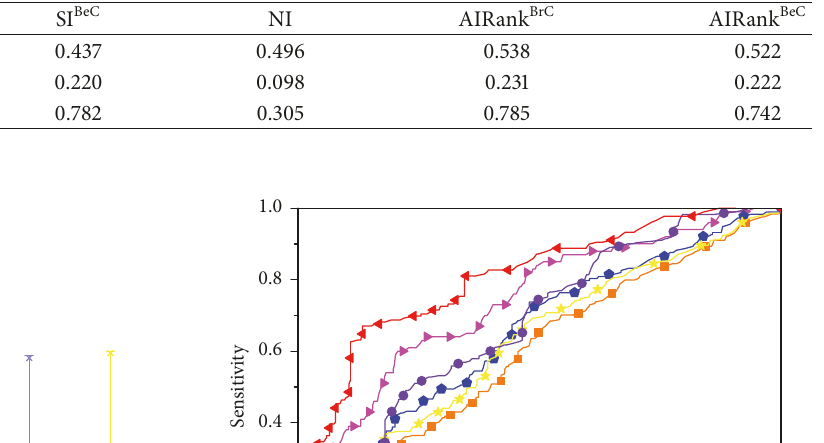
Table 4: Comparison of Pearson Correlation Coefficient.